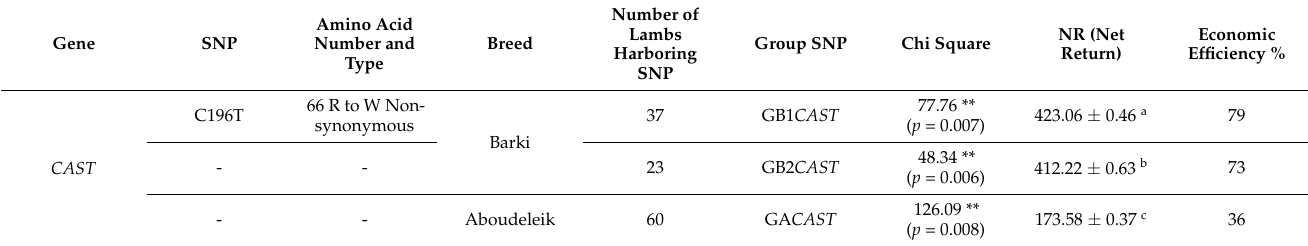
Table 7. Distribution of SNPs, type of mutation in growth -related genes and their association with economic parameters in Barki and Aboudeleik